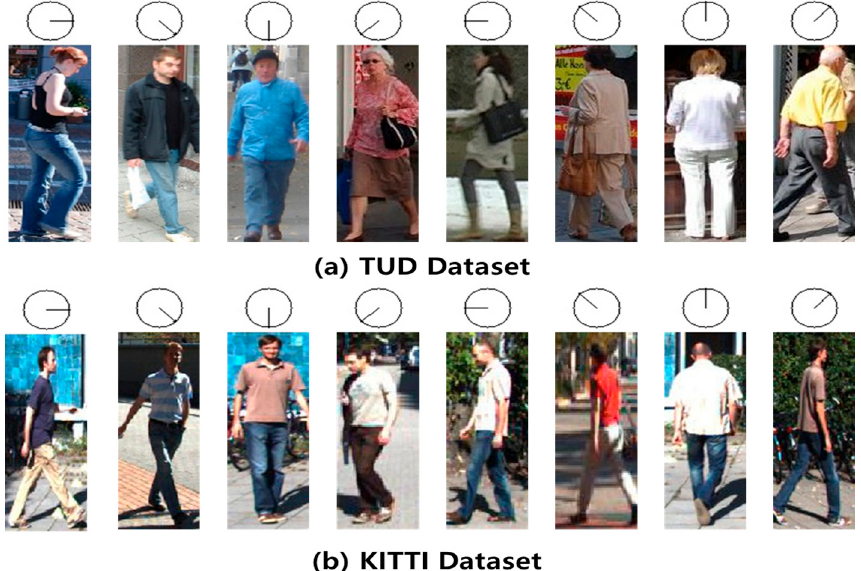
Figure 5. Sample orientation classification results for TUD and KITTI datasets using the proposed method: ( a ) estimation of pedestrian’s body orientation using TUD dataset, ( b ) results of pose orientation estimation (POE) using KITTI.